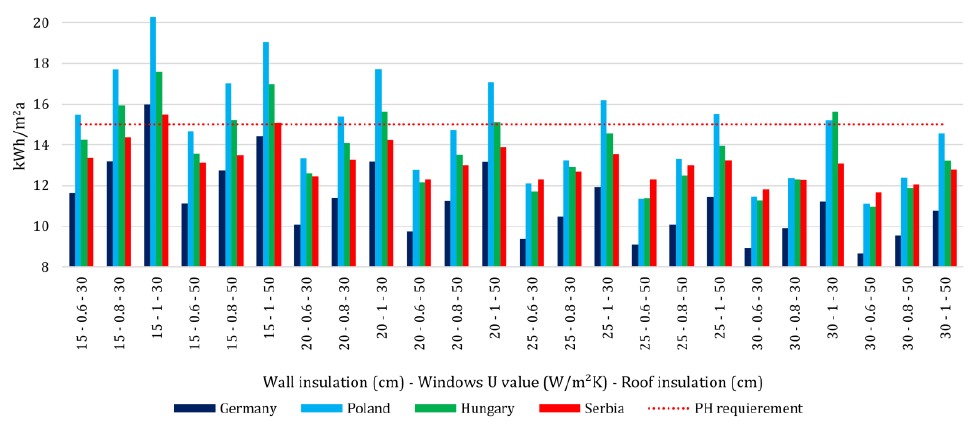
Figure 6. Energy consumption per m 2 of net living space.